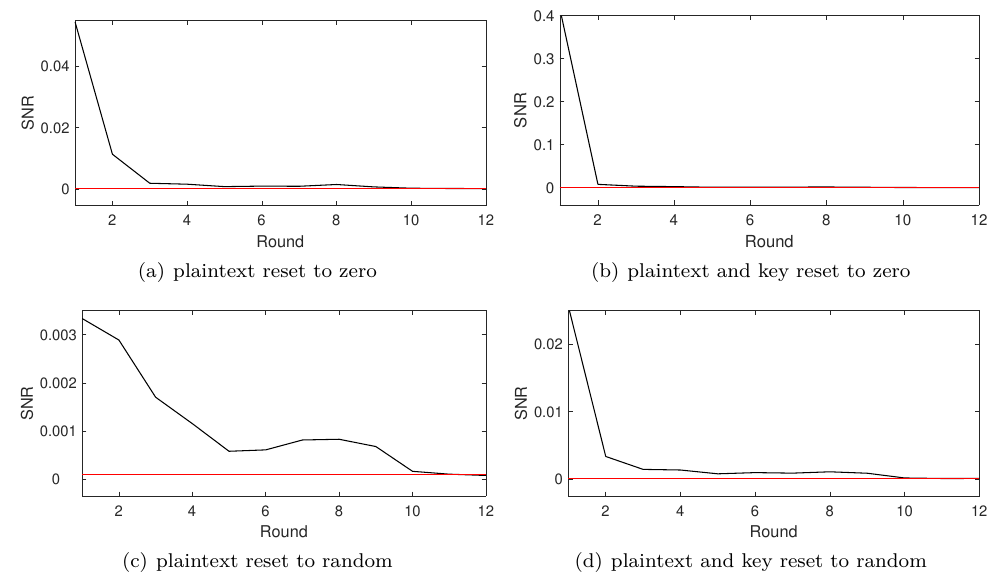
Figure 9: Maximum (nibble wise) signal-to-noise ratio (SNR) computed for all 12 round inputs for 4 different reset methods.